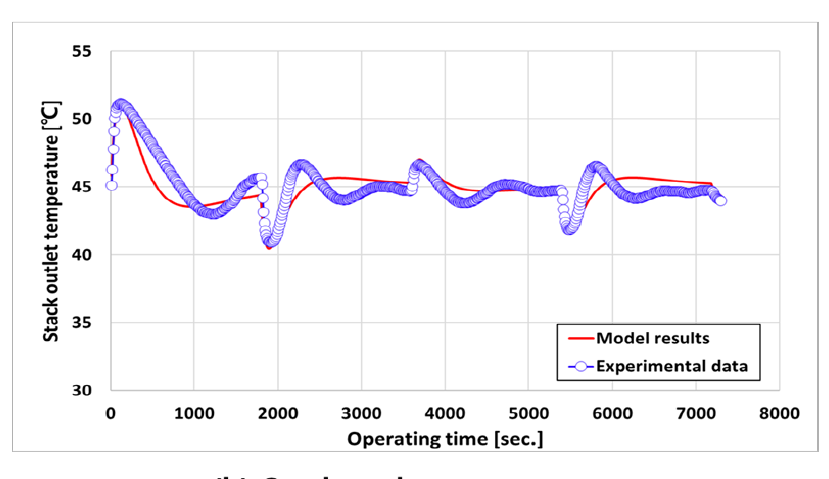
Figure 5. Temperature transient response of ( a ) stack inlet and ( b ) outlet by current load change.